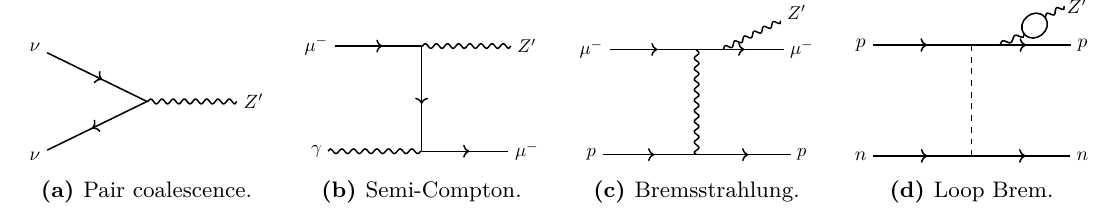
Figure 1. Supernova processes which may lead to anomalous energy loss for a Z 0 coupled to muon number. The dashed line in diagram (d) represents exchange of nuclear forces. Note that crossed versions of these diagrams contribute to the cross section